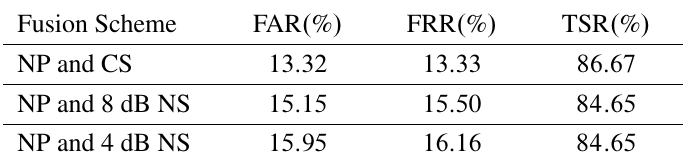
Table 8. Verification rate of match score level fusion of noisy palmprint using ICA I MM with speech (clean and noisy).